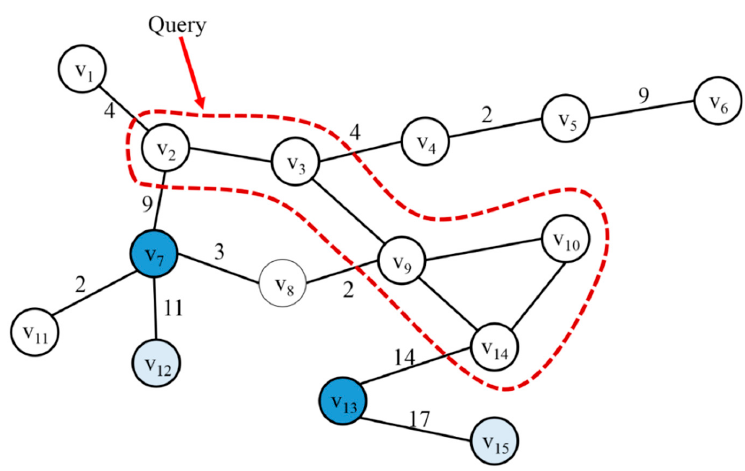
Figure 5. Neighbor vertex caching according to graph query.